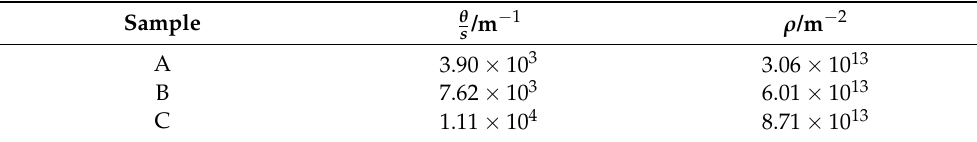
Table 7. Dislocation density, ρ , calculated using Equation (1). Values of θ were measured during EBSD of the as-stabilized material, and s is the step size of the EBSD